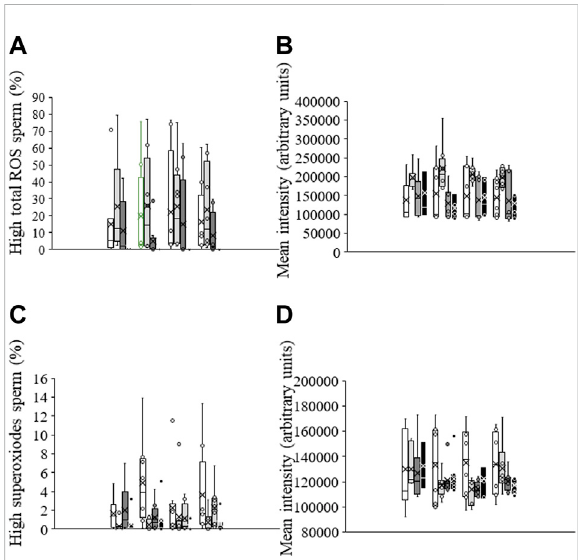
FIGURE 3 Box-and-whisker plot of the effects of antimycin A and PKCi on intracellular levels of total ROS and superoxides. Sperm were subject to separate red LED light irradiation patterns in the presenceof1 µMantimycinA,100 nM PKCiorbothtogether, and parameters related to ROS were analyzed as described in Materials and Methods section. Sperm were not irradiated (white boxes) or irradiated with red LED light for 1 min (light grey boxes), 5 min (dark grey boxes) or 10 min (black boxes) in the absence (C) or presence of 1 µM antimycin A (AA), 100 nM PKCi (P) or 1 µM antimycinAand100 nMPKCi together(AA+P). (A) percentagesof viable sperm with high ROS levels. (B) Fluorescence intensity of DCF + inthepopulationofviablespermwithhighROSlevels(DCF + / PI − ). (C) percentages of viable sperm with high superoxide levels. (D) Fluorescence intensity of E + in the population of viable sperm with high superoxide levels (E + /YO-PRO-1 - ). Figure shows means ± S.E.M. for eight biological replicates involving eight independent samples. Asterisks inside boxes indicate means, whereas lines inside represent